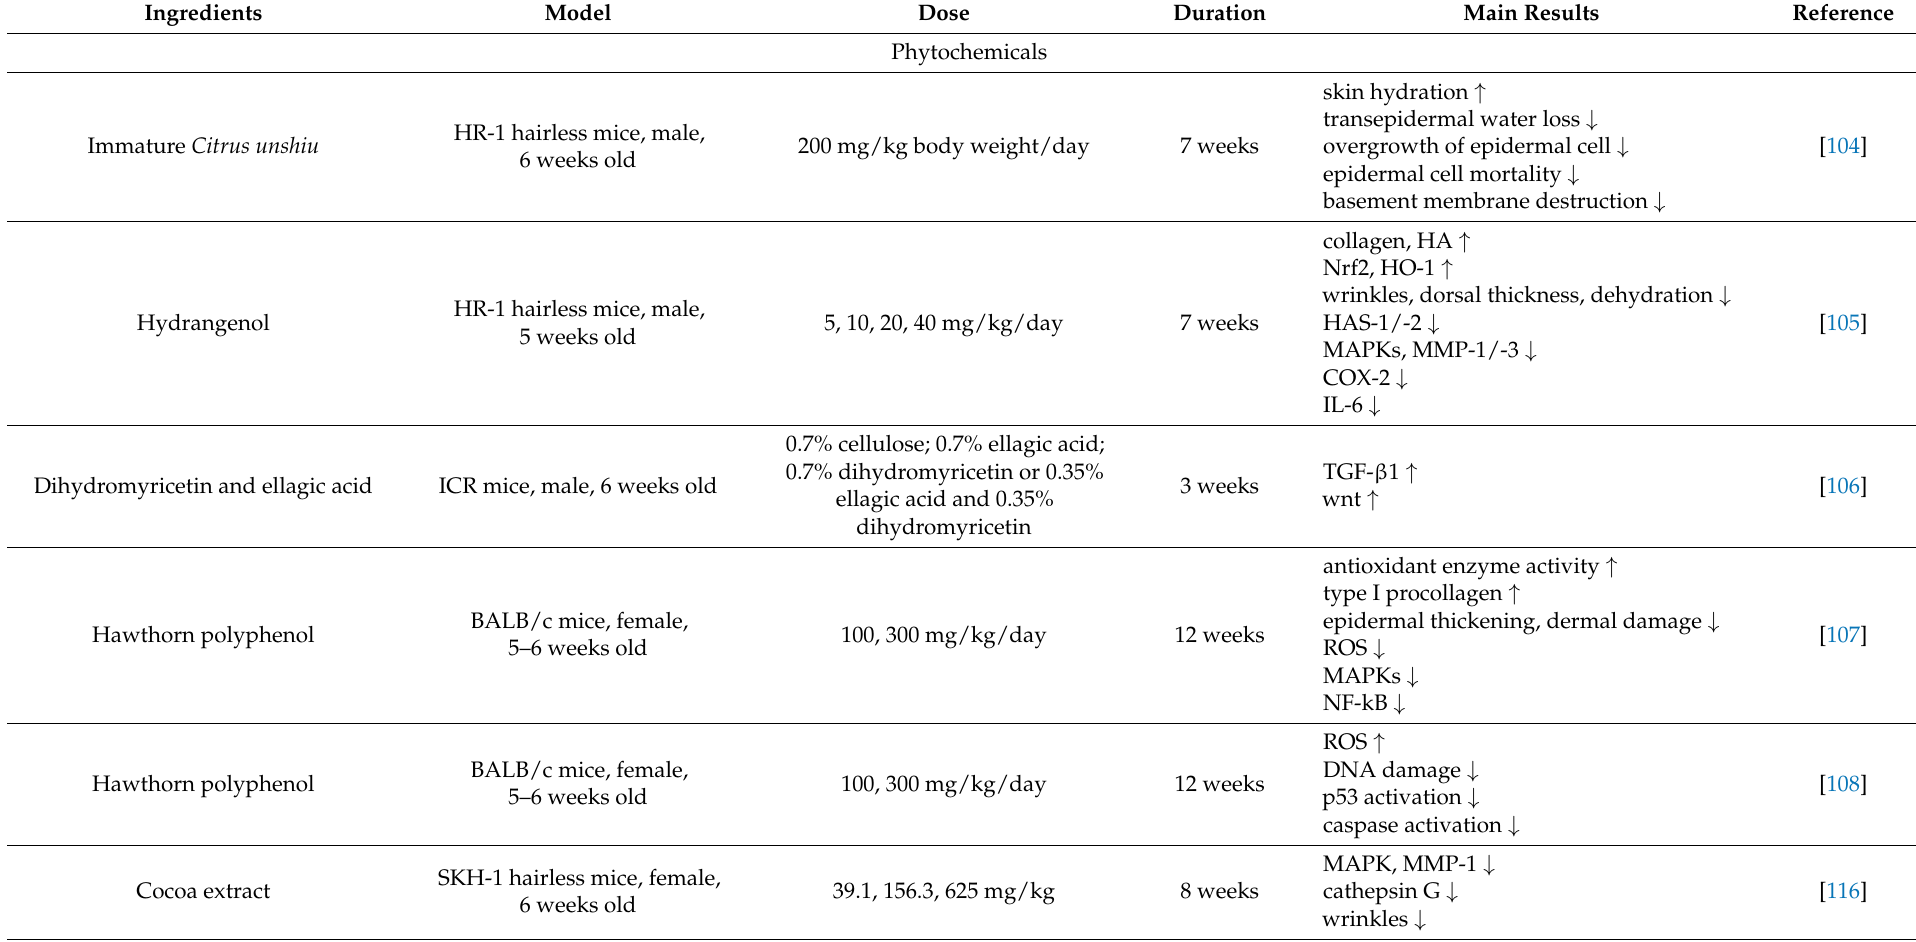
Table 1. Summary of dietary components to boost photoaged skin in animal